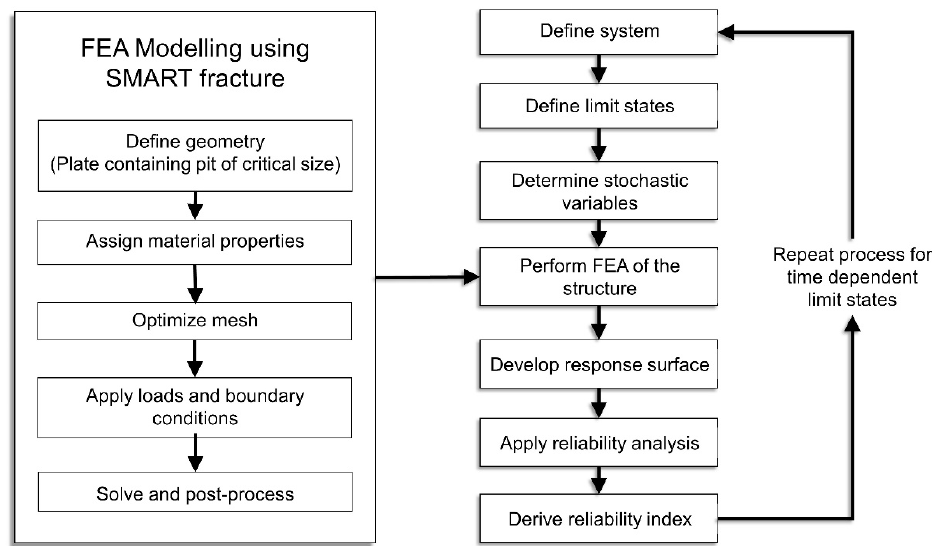
Figure 5. Flowchart of a proposed non-intrusive formulation. See [2] for more details. Reprinted with permission from [2]. Copyright 2020, Wiley.